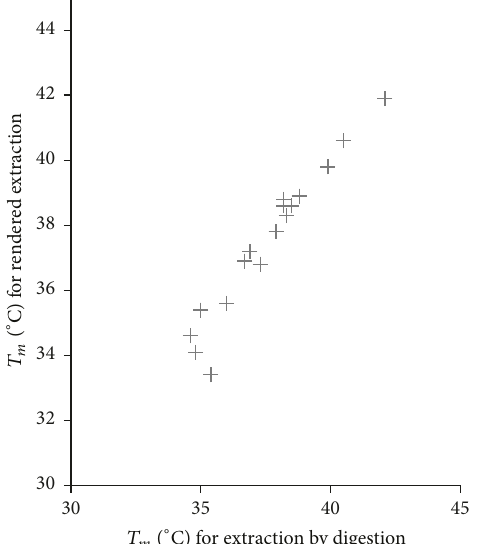
Figure 4: Simultaneous extraction of fat and DNA does not change 𝑇 𝑚 . There is excellent correlation between harvested during DNA and extracted by rendering (Pearson’s 𝑅 = 0.97 ). There was no measurable bias (mean difference 0.13, SEM = 0.14). Either extraction method can be used for direct comparison without